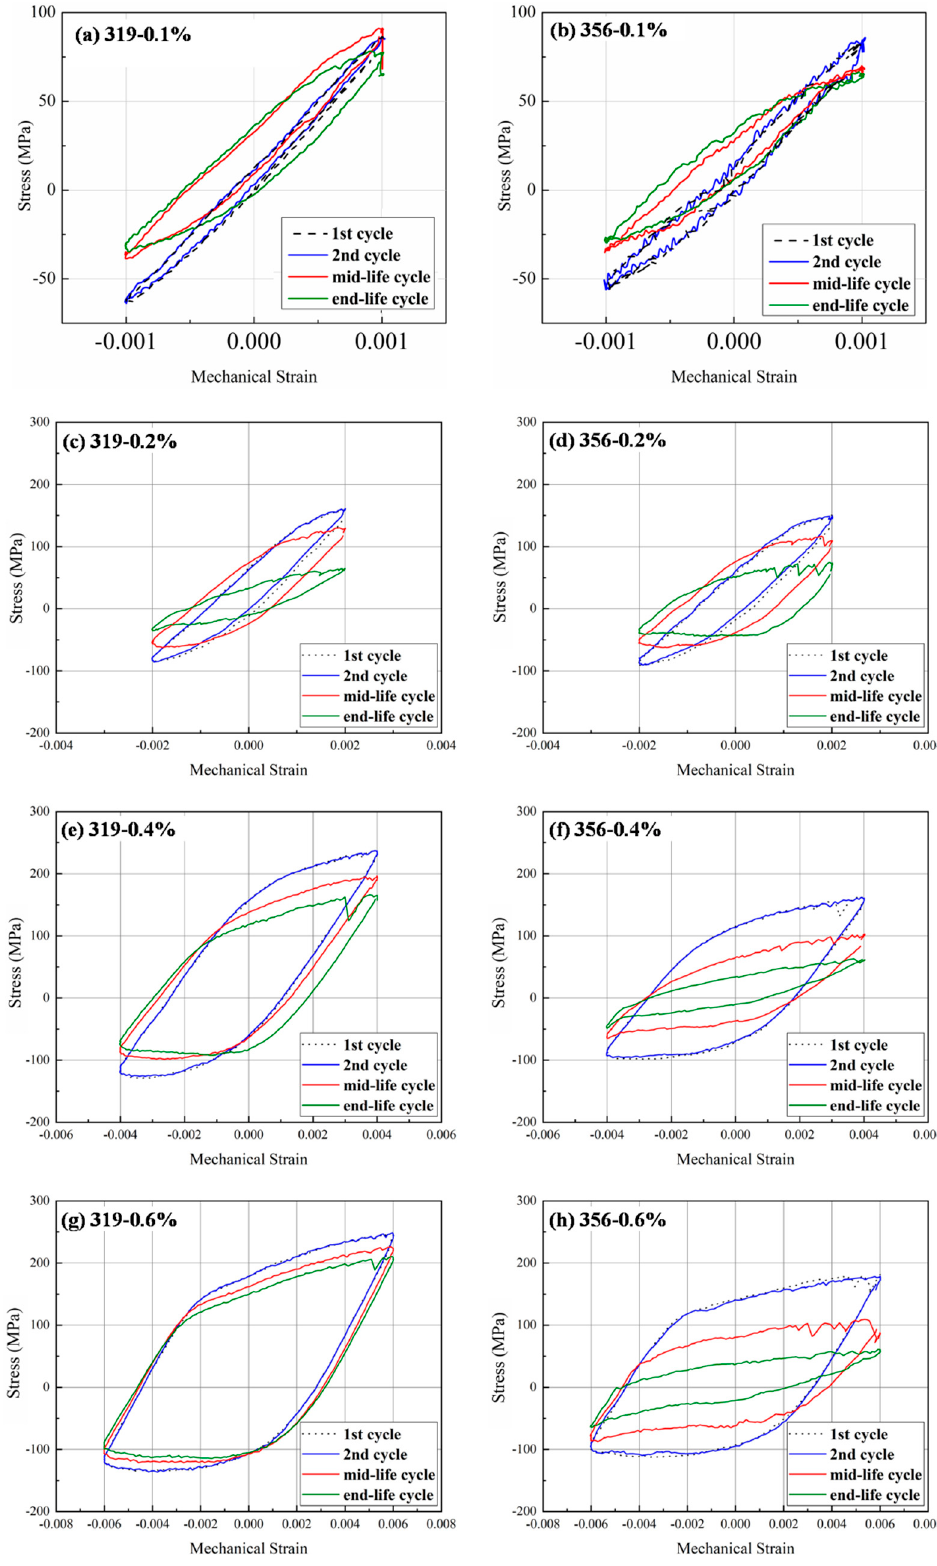
Figure 2. OP-TMF stress–strain hysteresis loops for experimental alloys at different strain amplitudes of 0.1, 0.2%, 0.4%, and 0.6%: ( a , c , e , g ) 319 alloy; ( b , d , f , h ) 356